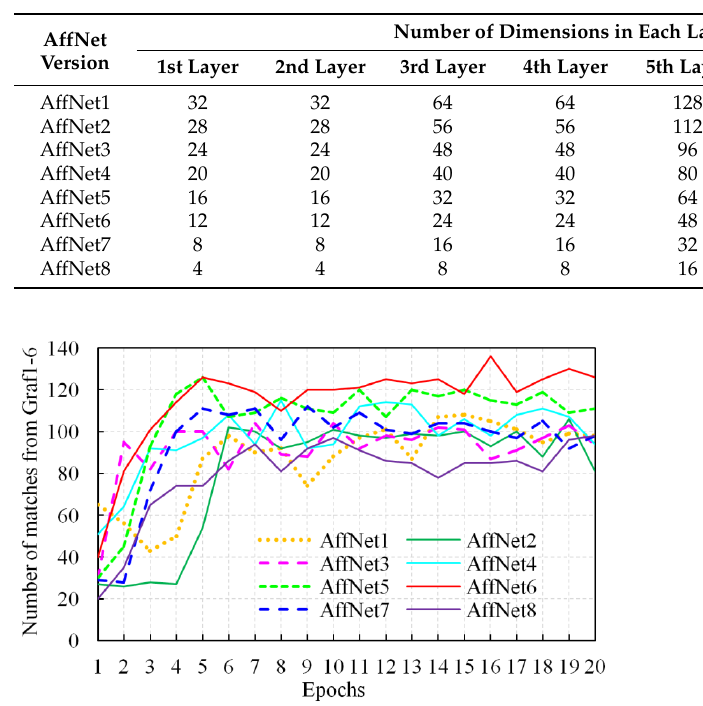
Table 1. Multiple versions of AffNet with different number of dimensions.